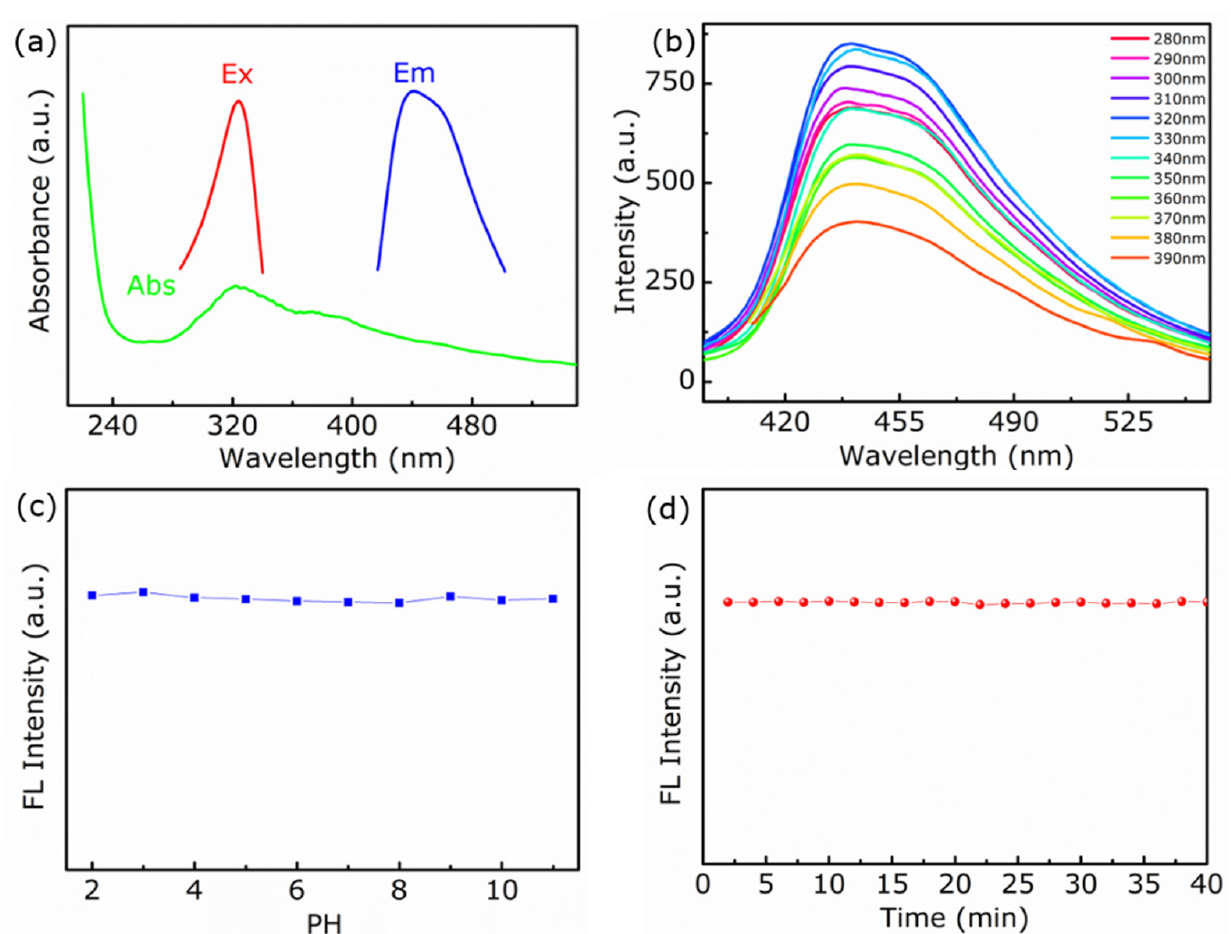
Figure 5. ( a ) UV–visible absorption and emission spectrum of OCNQDs. The excitation and emission wavelengths are 440 nm and 320 nm. ( b ) Fluorescence spectra at different excitation wavelengths ranging from 280 nm to 390 nm. The effect of ( c ) pH and ( d ) irradiation on the fluorescence intensity of OCNQDs.